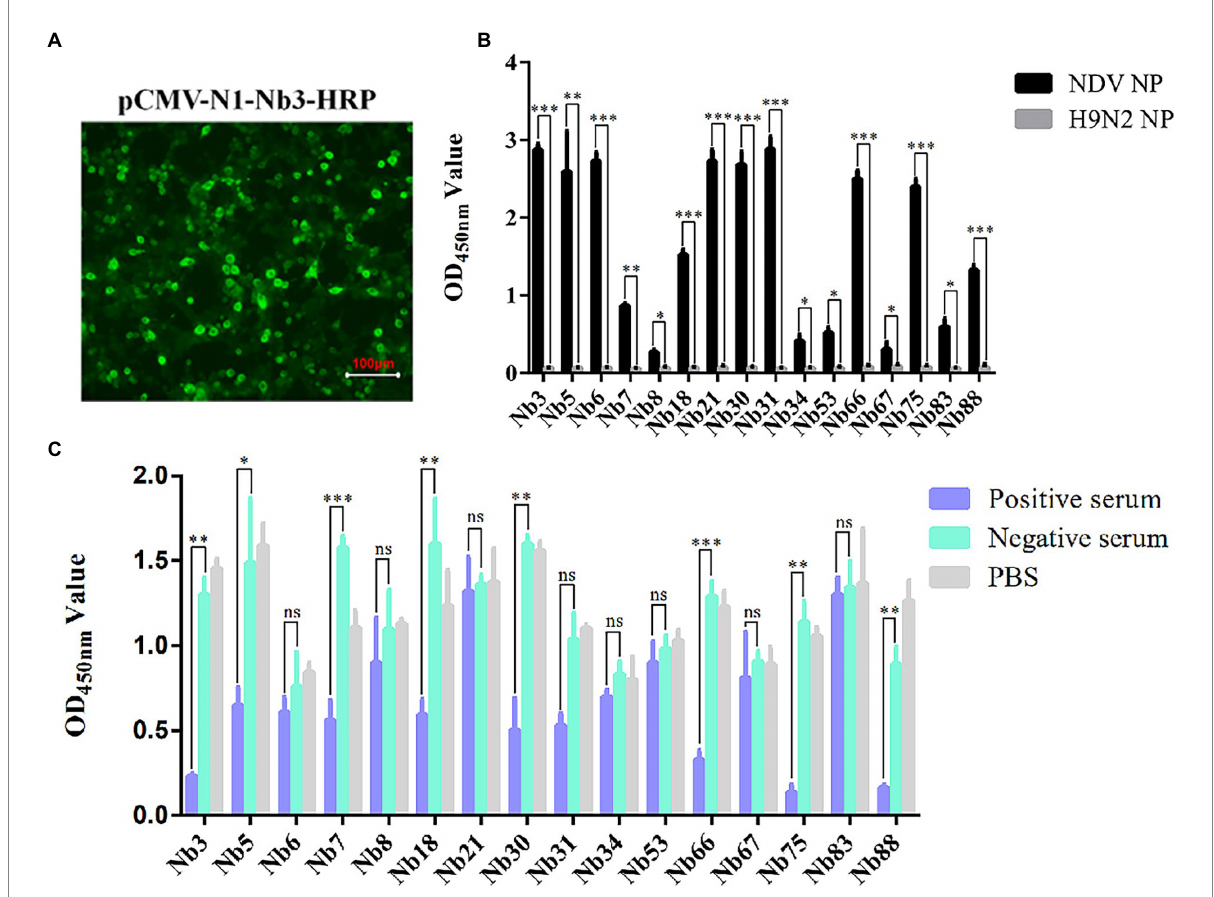
FIGURE 2 Secreted expression of nanobodies with HRP fusion proteins against NDV NP protein in the HEK-293 T cells. (A) Detection of nanobodies with HRP fusion protein expressed in the HEK-293 T cells via IFA using anti-HA mAbs as primary antibodies. HEK-293 T cells transfected with pCMV- N1-Nb13-HRP plasmids were selected and the cells transfected with other recombinant nanobody plasmids were treated in a similar manner. (B) Supernatants containing 16 nanobodies with HRP fusion proteins against NDV NP proteins were detected using direct ELISA. (C) Interactions between nanobodies with HRP fusion proteins and NDV NP proteins were blocked by the positive chicken sera for antibodies against NDV with competitive ELISA. The results were performed in triplicate and data are presented as the mean ± SD. * p < 0.05; ** p < 0.01; *** p < 0.005 (two-tailed Student’s t